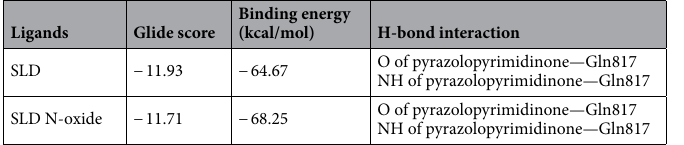
and medicinal herbs 37 . Monitoring of the cages showed that the males treated with SLD and SLD N-oxide reacted